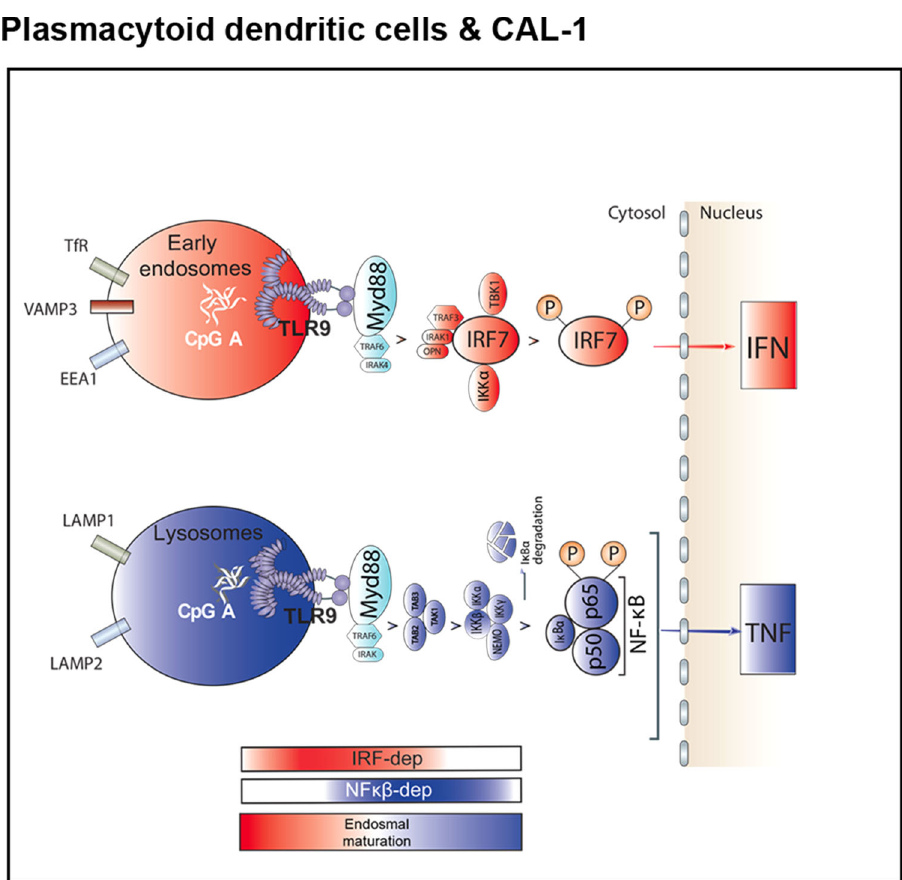
Fig. 2 Graphical abstract of TLR9 traf fi cking and signalling in human pDCs. a Graphical abstract summarizing the results shown in Fig. 1 on the spatiotemporal organisation of endosomal TLR9 signalling in human pDCs. The bimodal regulation of TLR9 signalling as well as endosomal maturation is represented using rectangles in shading red for IRF7-dependent phase and early endosome and in shading blue for NF- κ B-dependent phase and